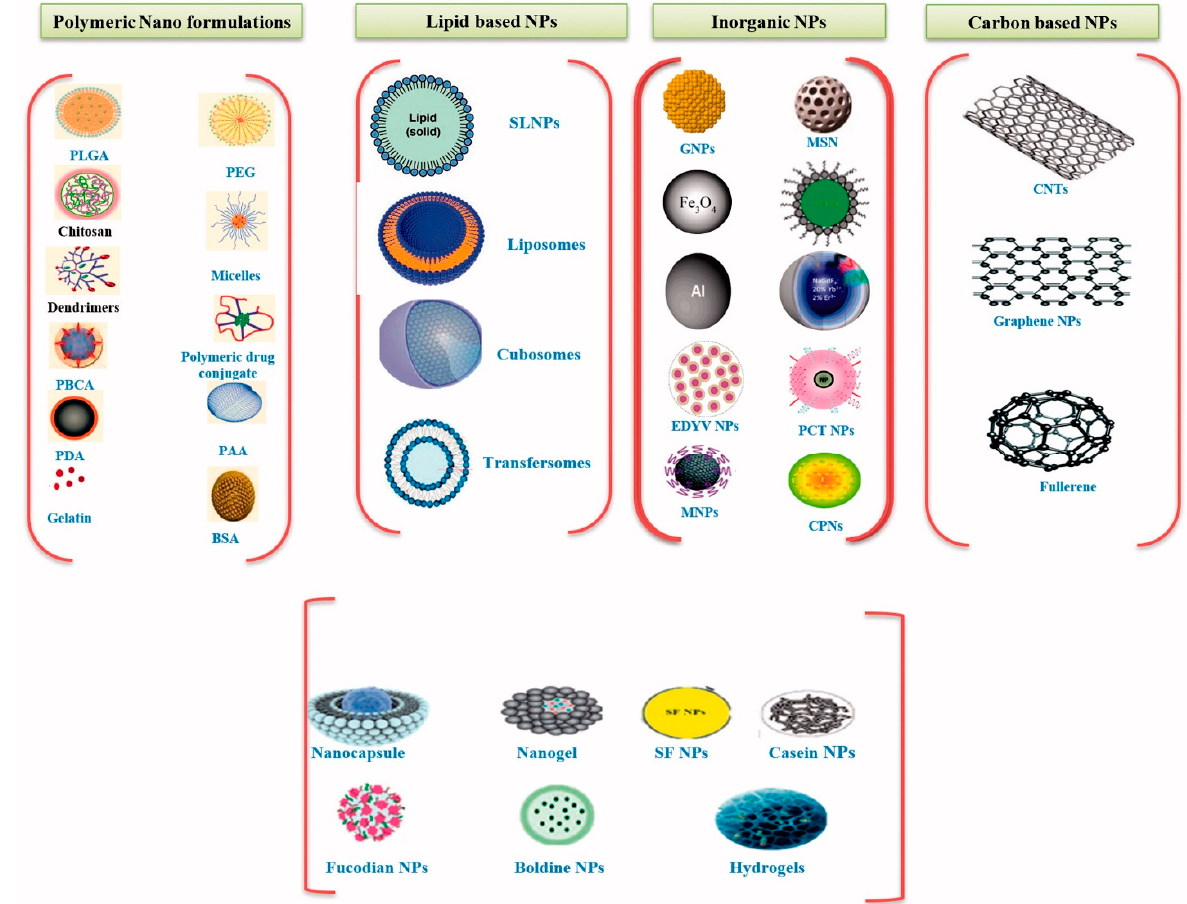
Figure 5. Various nanocarriers for anticancer drugs. Reprinted from an open-access source [94].